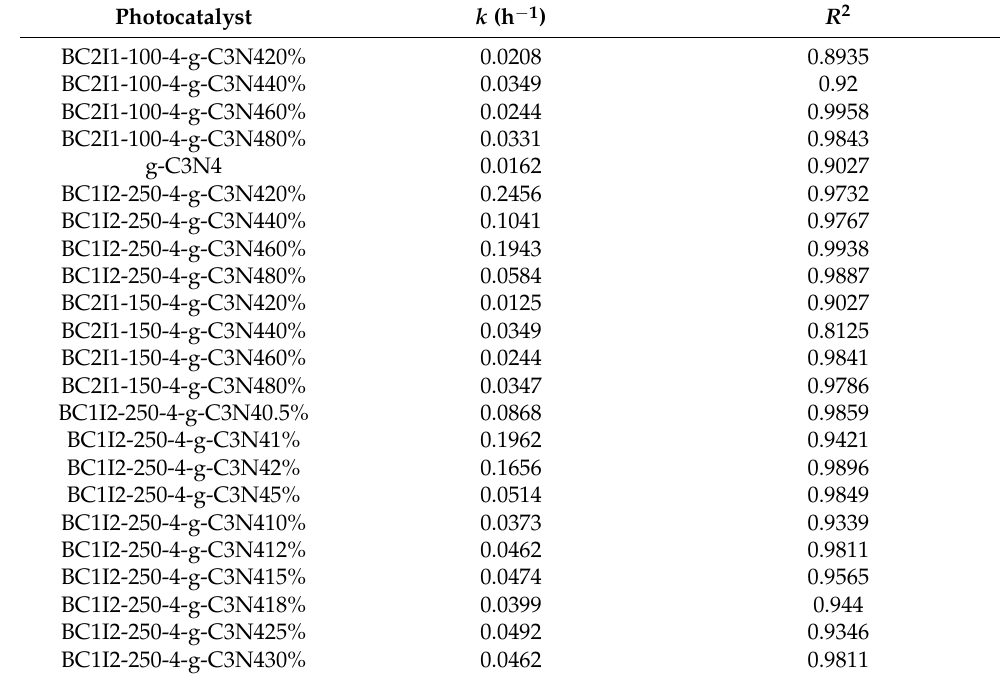
Table 3. Rate constants for the pseudo-first-order degradation of CV on the prepared BiO m Cl n /BiO p I q /g-C 3 N 4 samples under visible-light